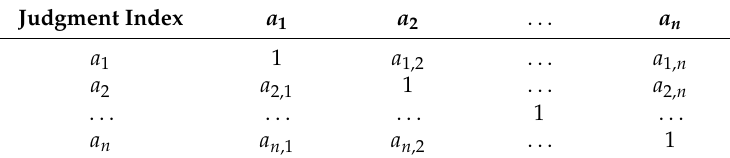
Table 2. Judgment matrix.